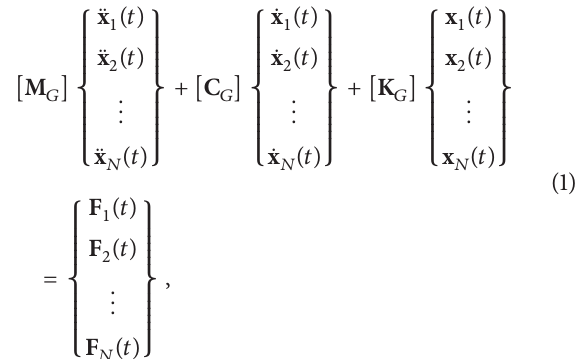
joint. The desire to (where possible) avoid using